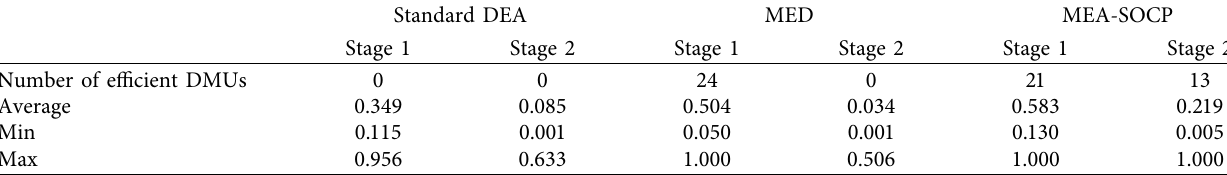
Table 5: Comparison of the discrimination across standard DEA, MED, and MEA.